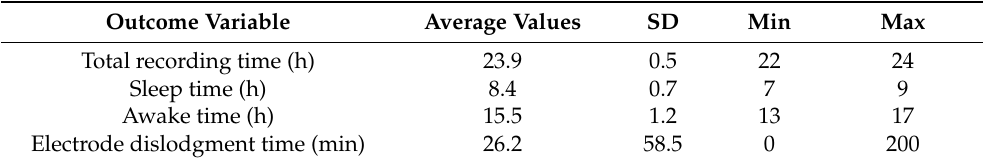
Table 1. Descriptive statistics of outcome variables over the 24 h EMG recording (mean values; standard deviations; min; and max).